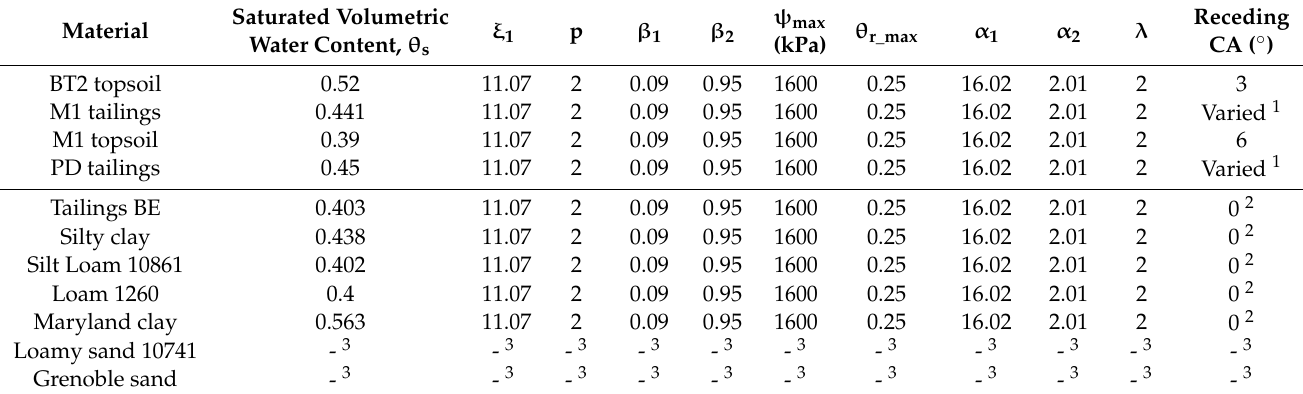
Table A8. Parameters used in the intergranular mixing particle size distribution model (IMP) for each material: saturated volumetric water content ( θ s ), parameter ξ 1 , parameter p, parameter β 1 , parameter β 2 , parameter ψ max , parameter θ r_max , parameter α 1 , parameter α 2 , parmeter λ , and receding contact angle (CA).